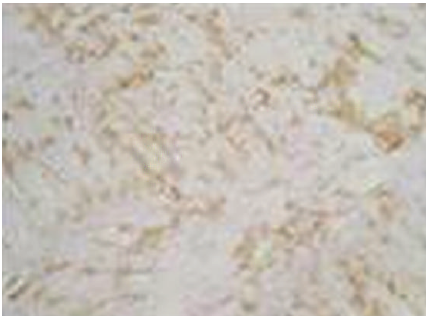
Figure 1: Clinical characteristics of the vascular leiomyomas. Multiple erythematous lesions on the tongue, cheek, and floor of the mouth were observed.